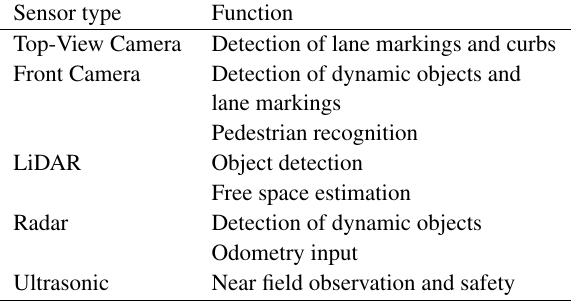
Table 1. Different sensor types integrated to